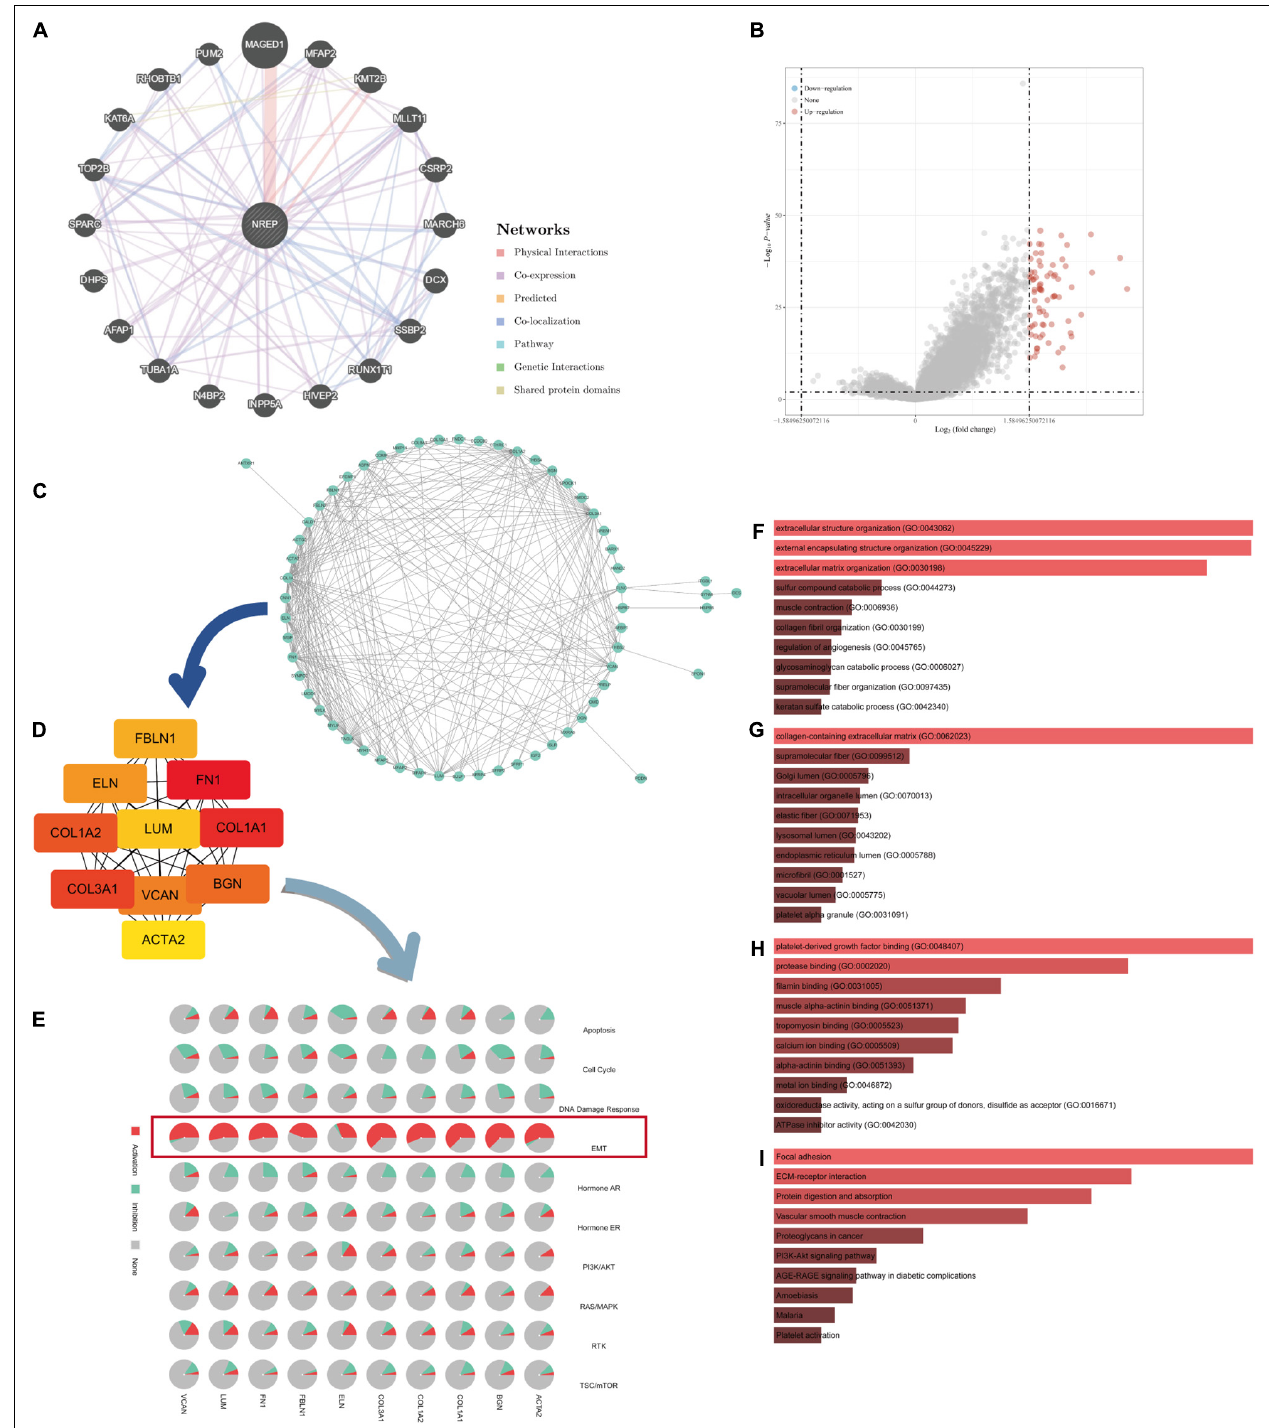
FIGURE 3 | Protein–protein interaction (PPI) network and enrichment analysis. (A) GeneMANIA-based PPI; NREP is at the core of this network. (B) Volcano map of genes showing differential expression after a change in NREP levels. Red dots, up-regulated genes; blue dots, down-regulated genes; abscissa, differences in gene expression (log2 fold change); and ordinate, significance of these differences ( − log10 padj). (C) Network of NREP and genes with NREP- linked expression (positive). (D) Hub gene network of NREP . (E) Relationship between hub genes and epithelial–mesenchymal transition. (F–I) Functional enrichment analysis of NREP -related genes. (F) Biological Processes (BP), (G) Cellular Components (CC), (H) Molecular Functions (MF), and (I) Kyoto Encyclopedia of Genes and Genomes (KEGG).